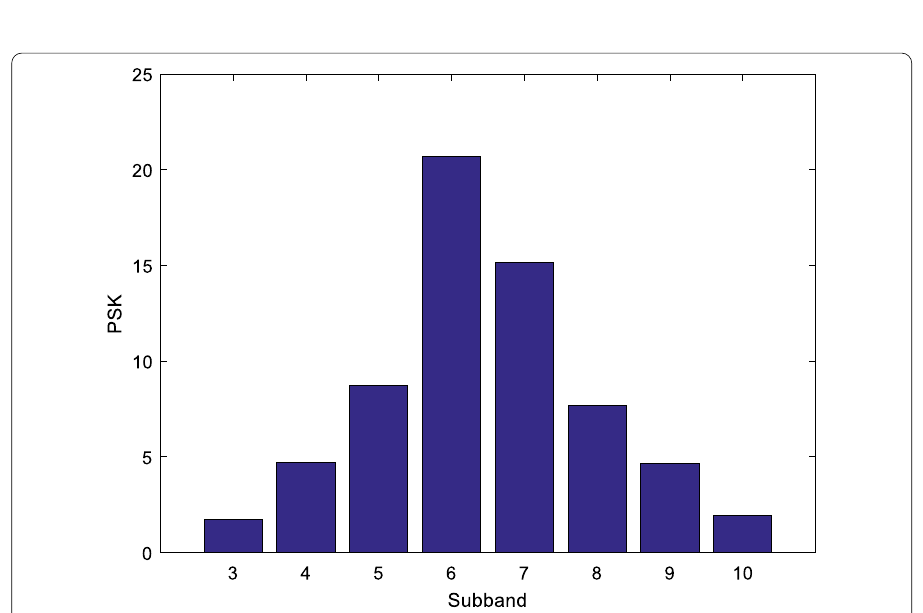
Fig. 13 Result of optimal characteristic sub-band selection. The figure shows the PSK value of each characteristic